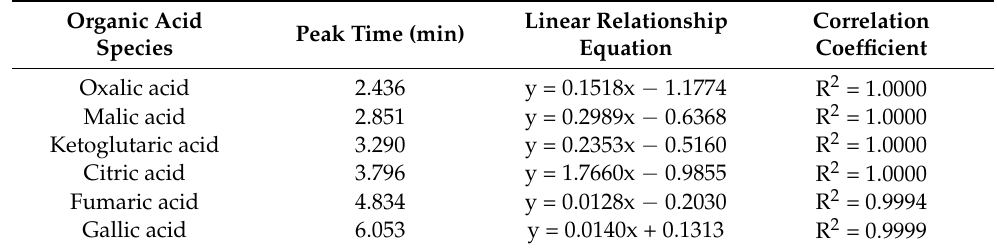
Table 1. The peak time, linear relationship and correlation coefficient for each acid component.